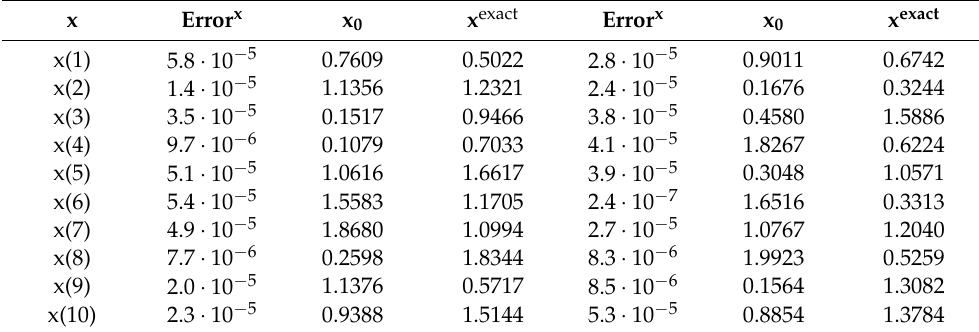
Table 8. Counterpart of Table 5 but using the 11 sensors considered in this section (which include data for P 45 t ) allowing for 2 (%) degradations. The exact values of T 4 t are 1349.2 K and 1303.0 K for the cases considered in columns 2–4 and 5–7, respectively. These exact values are computed by the method with an error smaller than 0.1